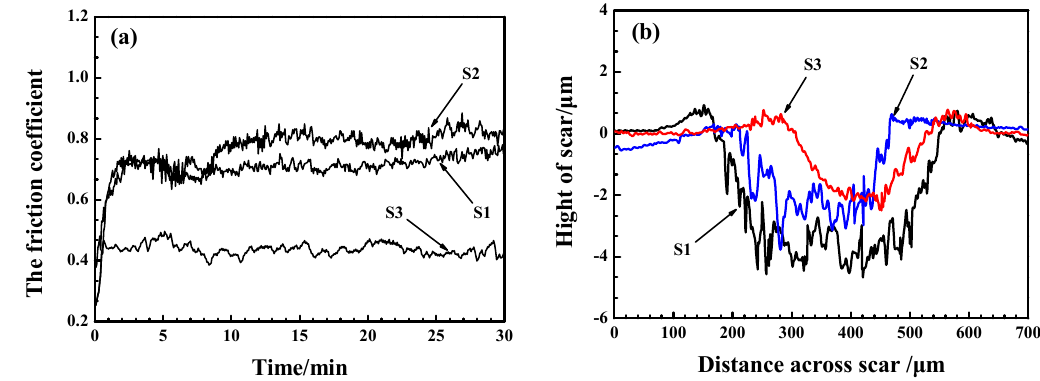
Figure 6. The friction coefficient curves of the laser cladded Fe ‐ based coatings ( a ) and typical cross ‐ sectional profiles of the wear tracks ( b ).